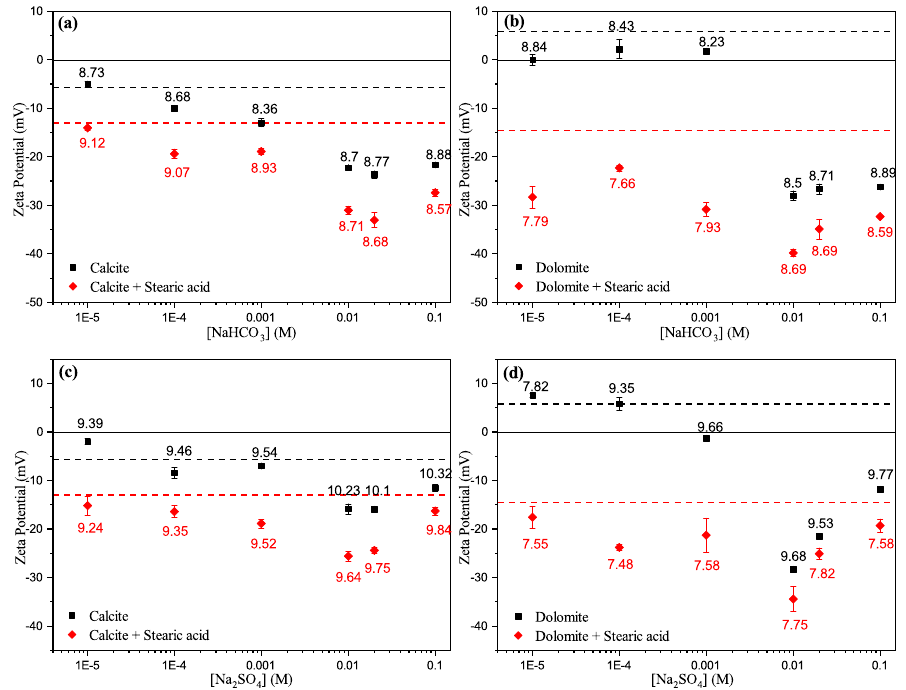
Figure 4. Comparison between the experimentally measured zeta potentials of unconditioned calcite and dolomite particles with the stearic acid-conditioned particles as a function of sodium bicarbonate ( a , b ), and sodium sulphate ( c , d ) aqueous electrolyte concentration. Measured pH values are reported above/below each point. Black dashed lines show zeta potential of the unconditioned carbonate particles in water and red dashed lines show zeta potential of stearic acid carbobate particles in